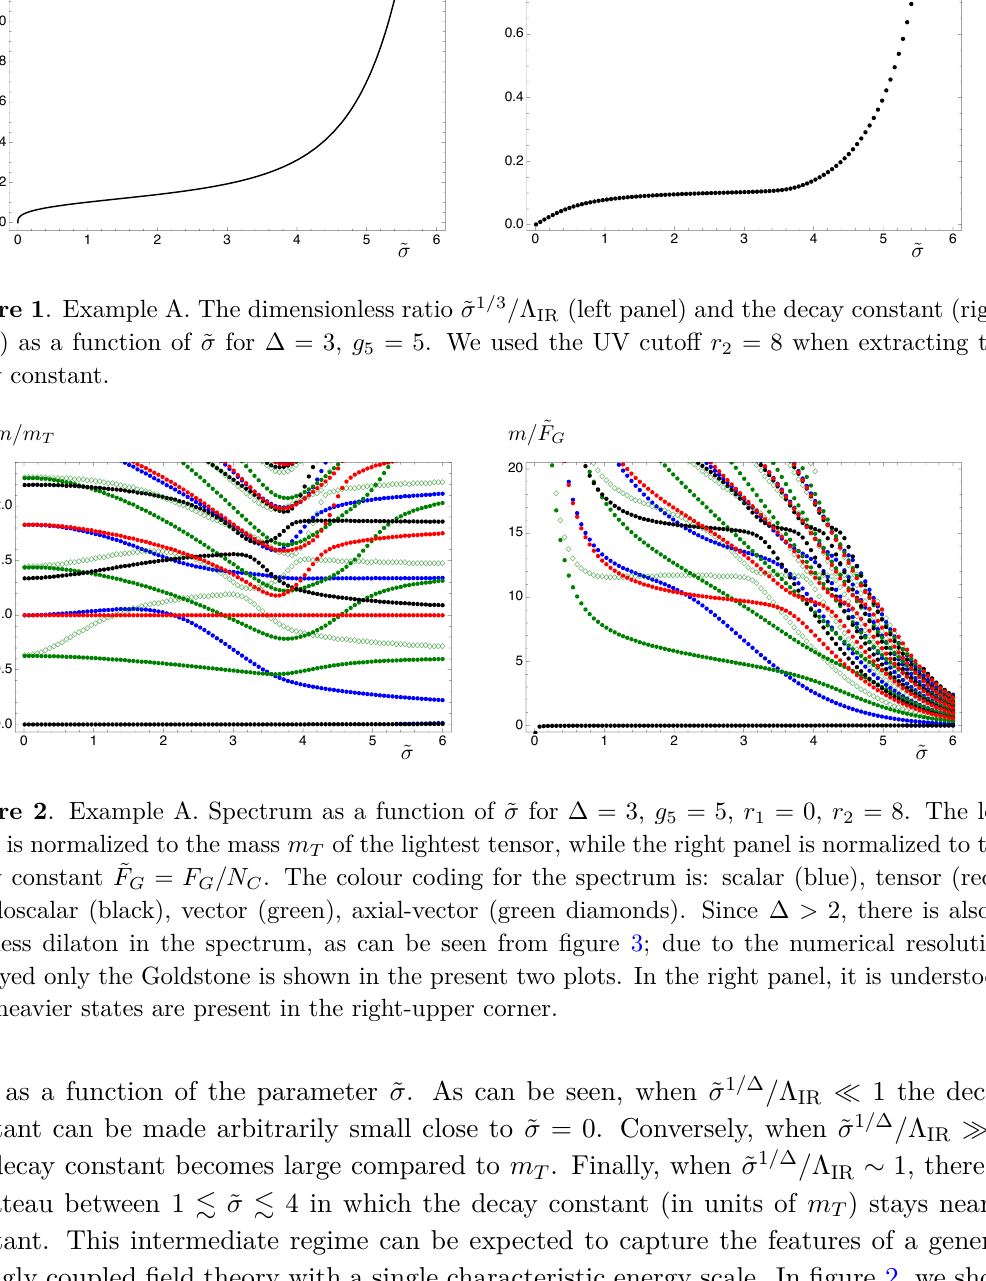
= 5 . We used the UV cutoff r 5